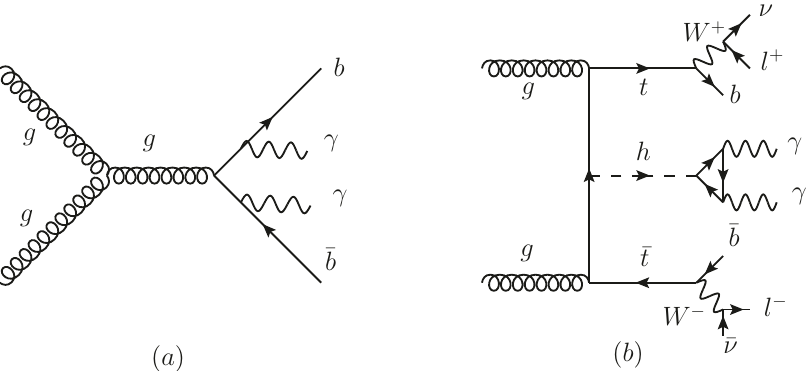
Figure 2 . Feynman diagrams illustrating the (a) b (cid:22) b(cid:13)(cid:13) and (b) t (cid:22) th background processes, corre- sponding to the b (cid:22) b(cid:13)(cid:13) search